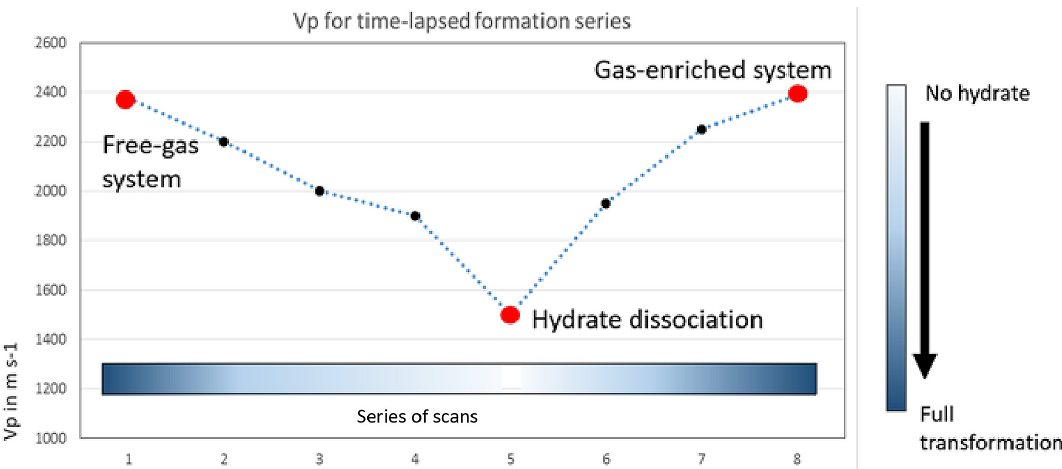
Figure 14. Results of the p wave modeling of a series of scans starting at the initial state forming hydrate from a free gas system up to the full-transformed state, followed by a controlled destabilization of the system to maintain hydrate dissociation from which again the hydrate formation was triggered up to a full-transformed state in a gas-enriched